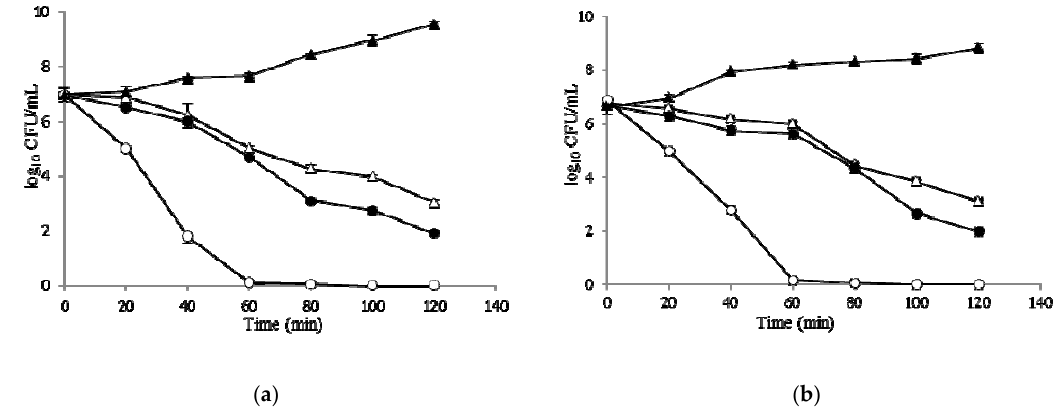
Figure 3. Bacterial-killing kinetics of BCN E 50-52 and thymol at 2× MIC against E. coli and S. aureus. ( a ) E. coli ; control (filled triangles), BCN E 50-52 512 µg/mL (filled circles), thymol 256 µg/mL (open triangles), BCN E 50-52 512 µg/mL and thymol 256 µg/mL (open circles); ( b ) S. aureus; control (filled triangles), BCN E 50-52 512 µg/mL (filled circles), thymol 256 µg/mL (open triangles), BCN E 50-52 512 µg/mL and thymol 256 µg/mL (open circles).